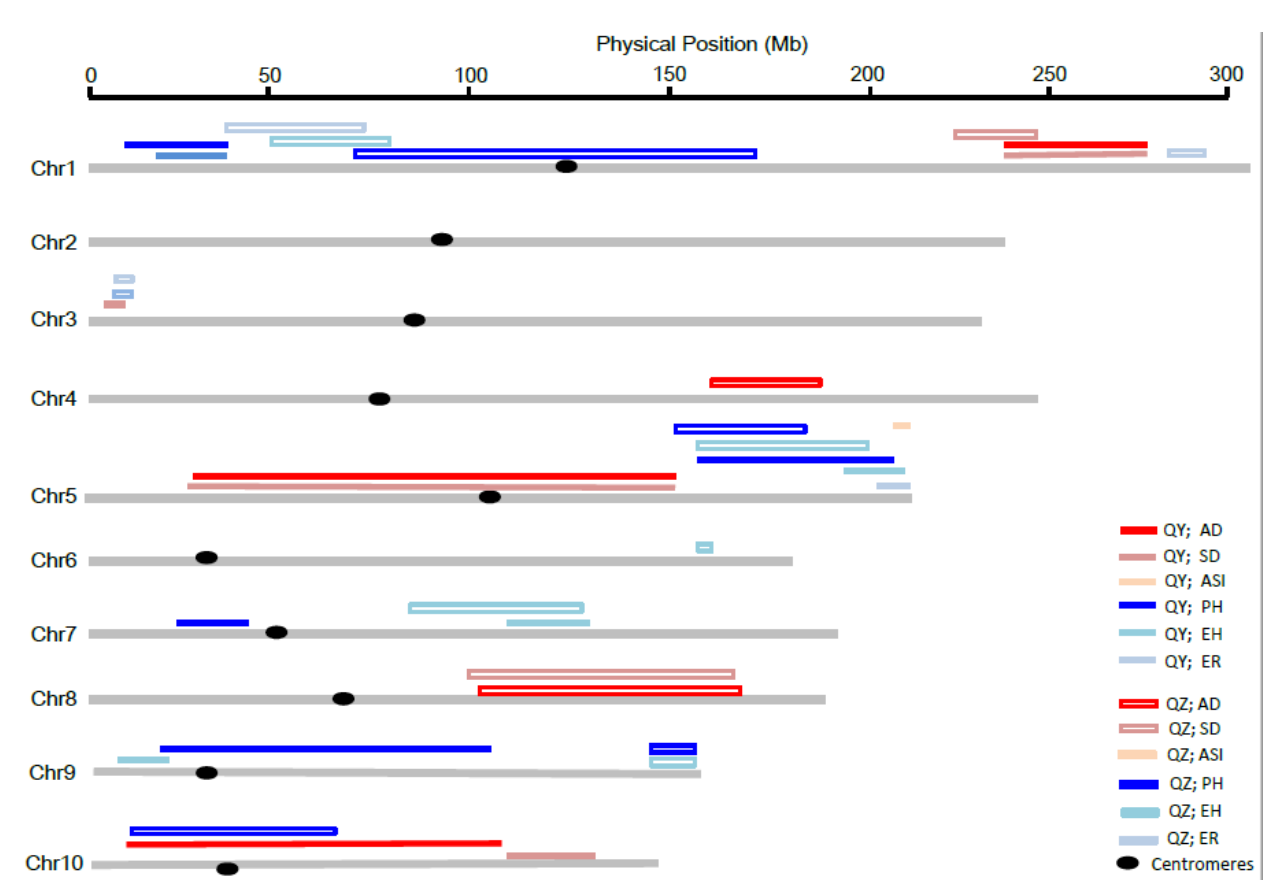
Figure 2. Distribution of QTLs for the six flowering time and height-related traits on the maize chromosomes. Colored lines depict QTL regions for different traits; the solid lines and hollow lines represent QTLs detected in the QY and QZ population, respectively, and the black spots represent centromeres. The red and blue colors represent flowering time and height traits, respectively, and the colors’ shading is used to distinguish the traits. The horizontal axes indicate the physical location in different chromosomes.